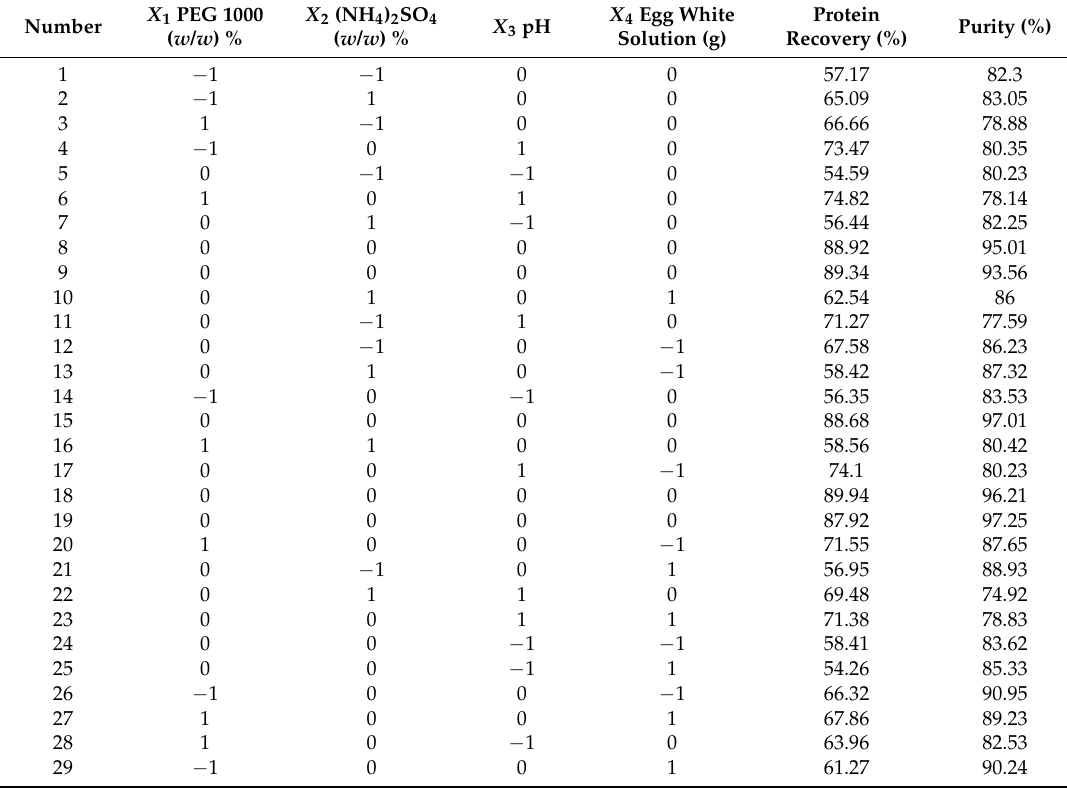
Table 2. Box-Behnken (BBD) and the results (means of triplicate tests) for the recovery yield and purification factor of OVA.